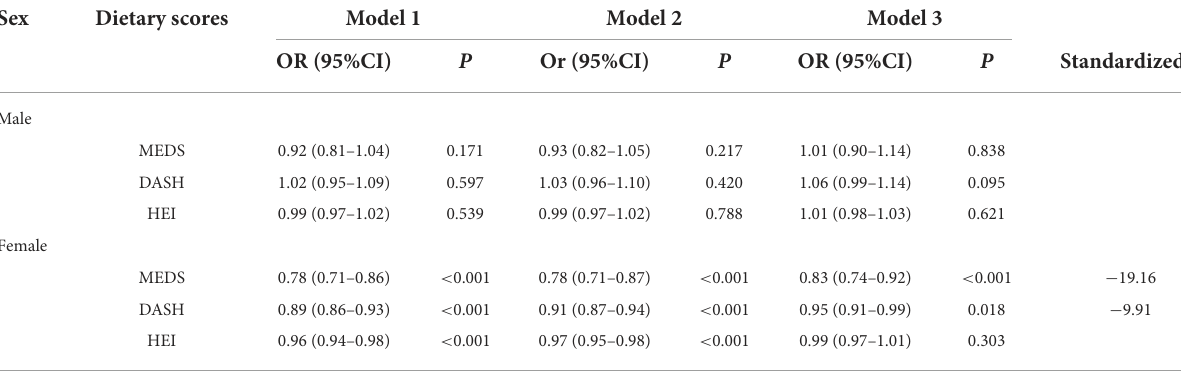
TABLE 4 Association analysis of dietary scores and depression in sex subgroups.